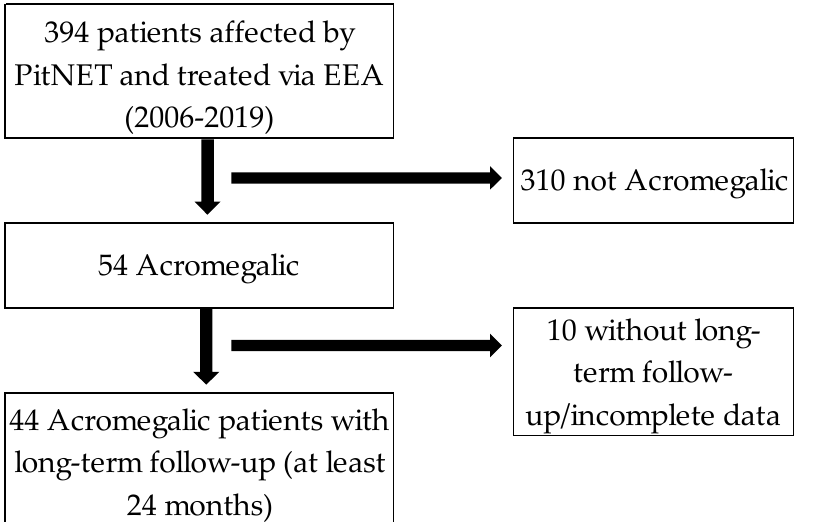
Figure 2. Inclusion criteria flow-chart. PitNET: Pituitary neuroendocrine tumors. EEA: Endoscopic endonasal approach.